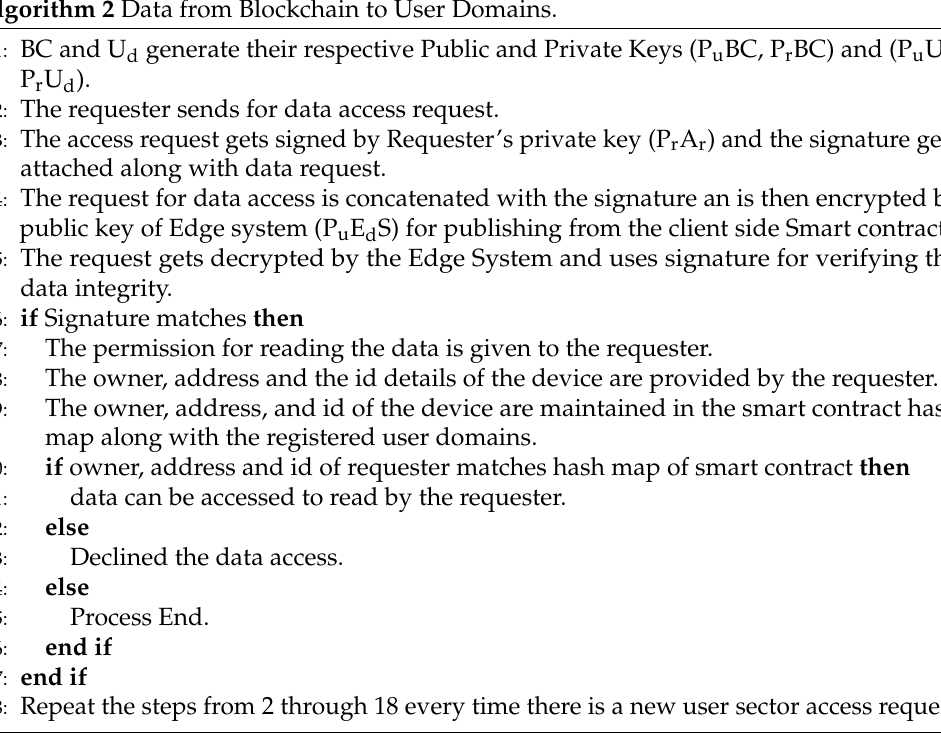
Algorithm 2 Data from Blockchain to User